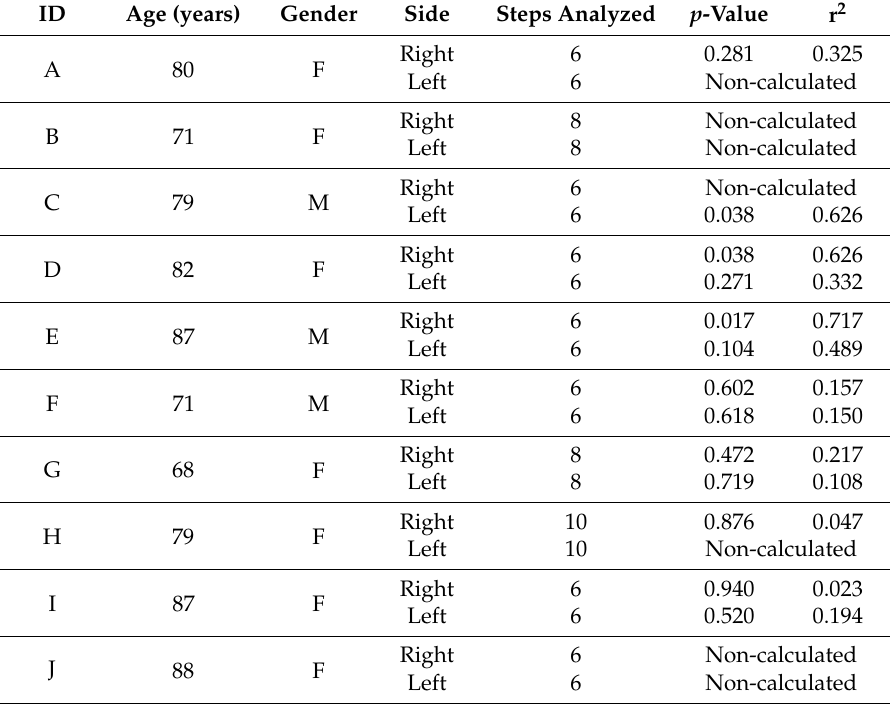
Table 4. Patient characteristics and result of correlation